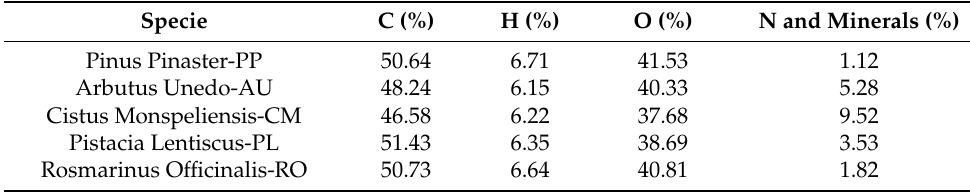
Table 1. Elemental composition of the biomass fuels.